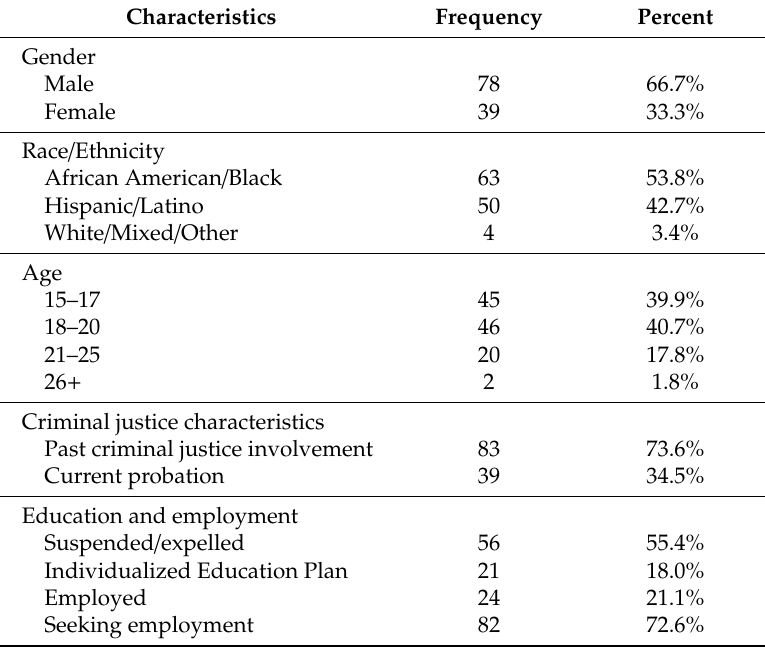
Table 1. Summary of New Directions’ student